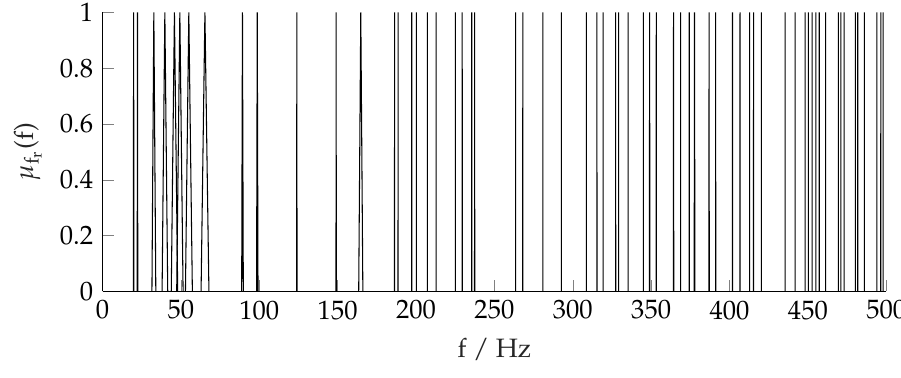
Figure 5. Fuzzy modes #1–#64.